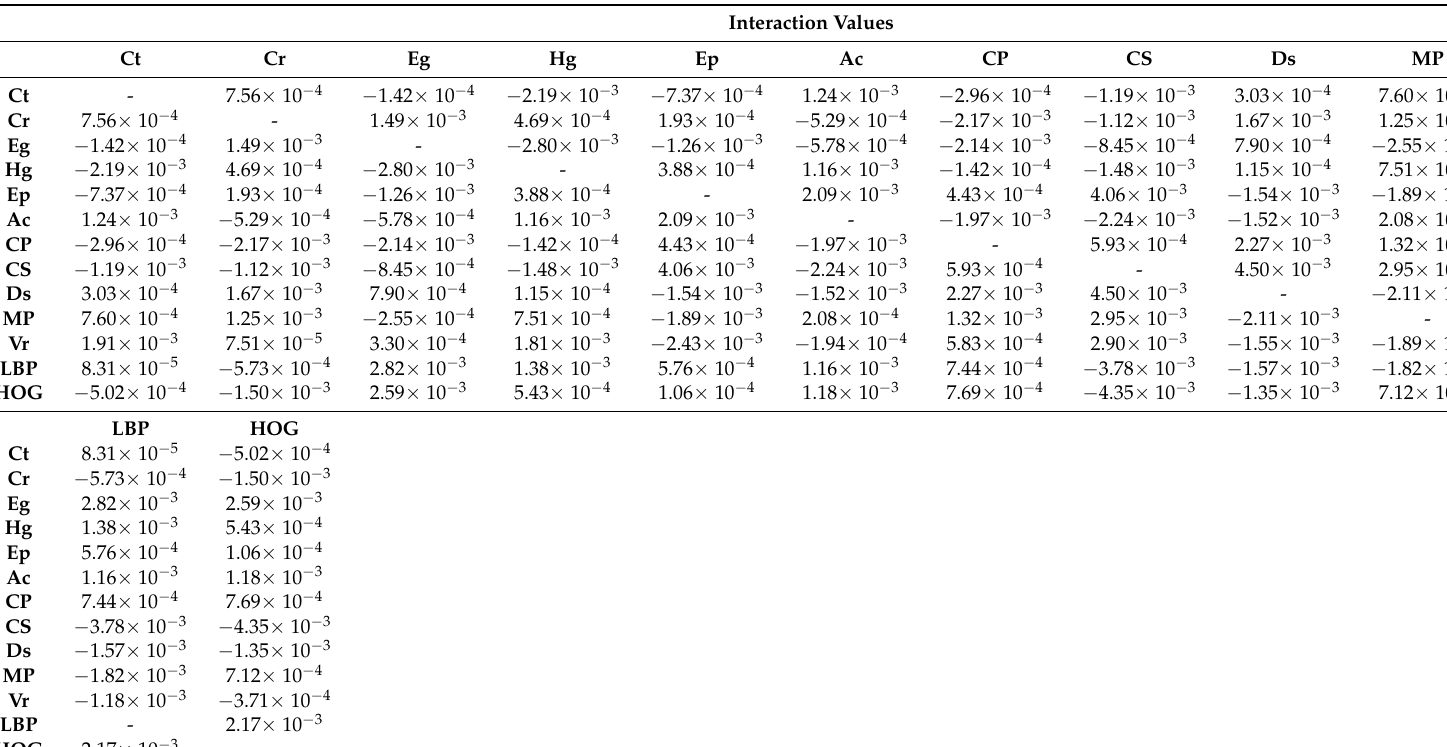
Table 3. A sample of interaction indexes of DECEDM texture